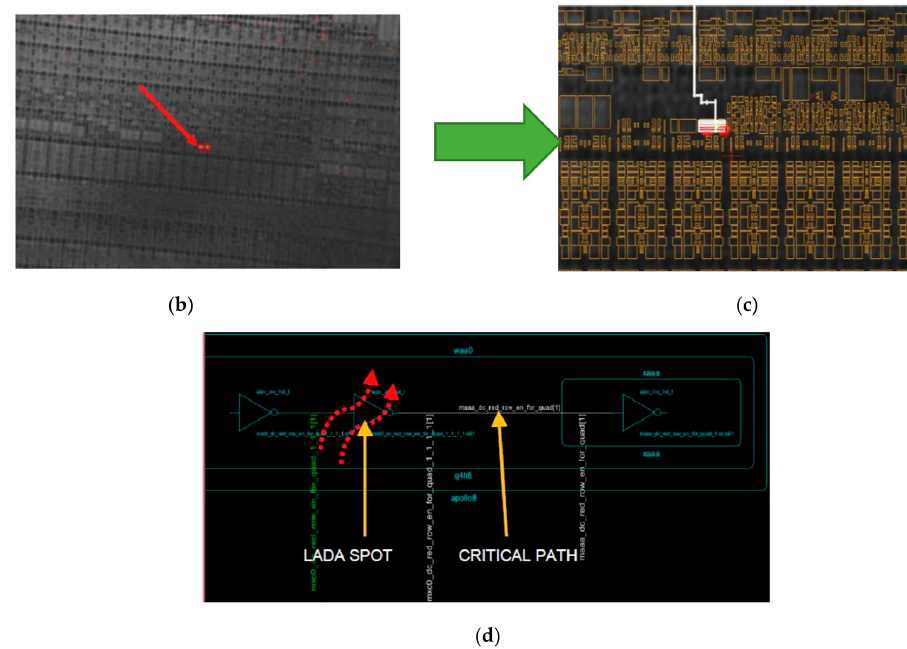
Figure 16. ( a ) Shmoo plot for failure between 1.25 V–1.30 V ( b ) Higher magnification of the LADA spot. ( c ) LADA spot on layout ( d ) The critical path from the LADA analysis was identified at the row decoder enable signal.